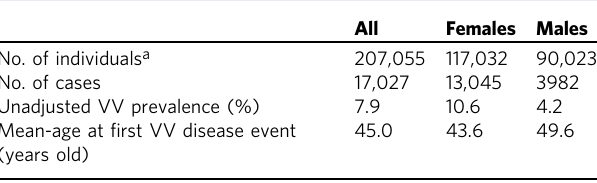
Table 1 The VV study cohort summary of the fi fth data release of